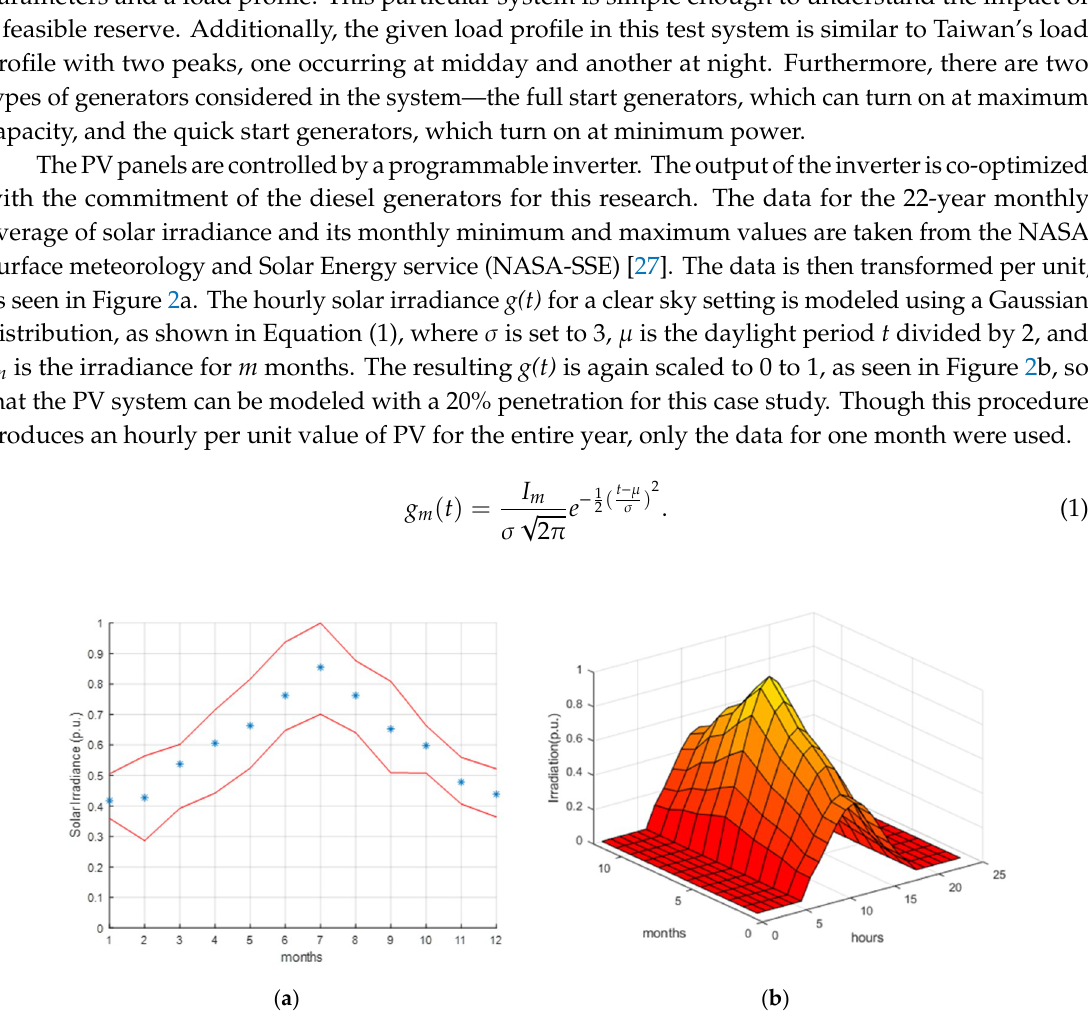
Figure 2. Solar irradiance: ( a ) monthly mean (1983–2005) in per unit from NASA-SSE and ( b ) the hourly irradiance per month in the per unit value.